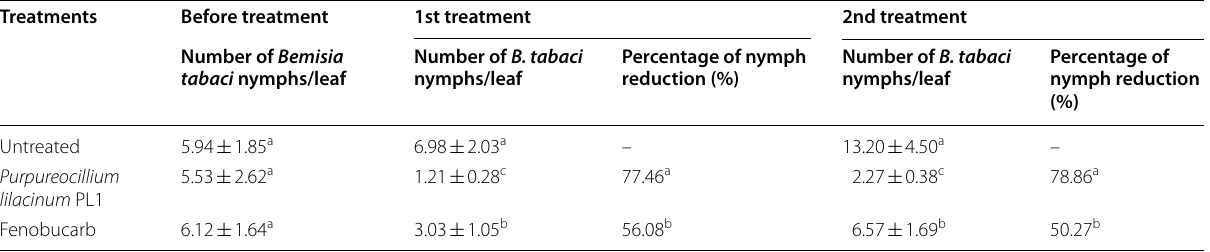
Different superscript letters (a–c) within a column indicate statistically significant differences between groups ( p < 0.05)